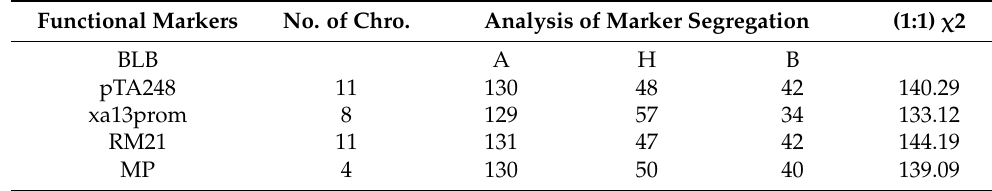
Table 4. The BC 2 F 2 progenies: Foreground marker segregation analysis. Functional Markers